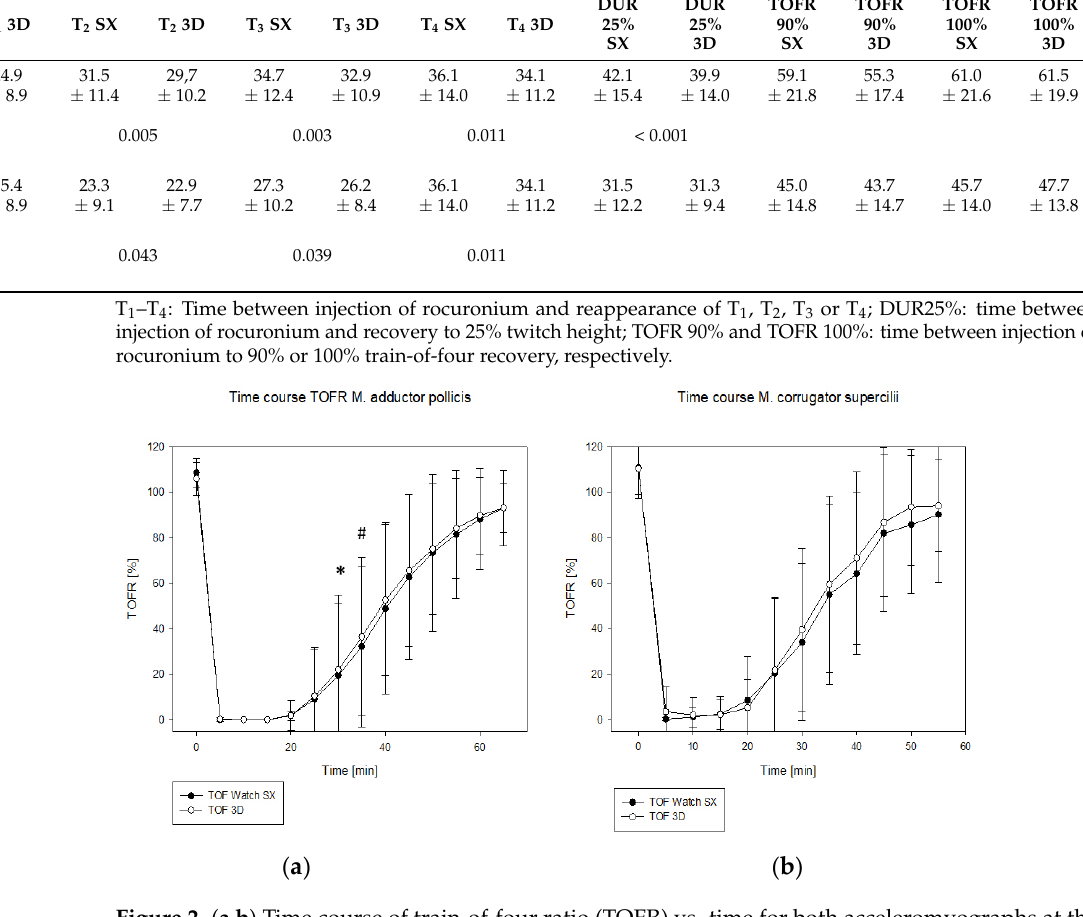
Figure 2. ( a , b ) Time course of train-of-four ratio (TOFR) vs. time for both acceleromyographs at